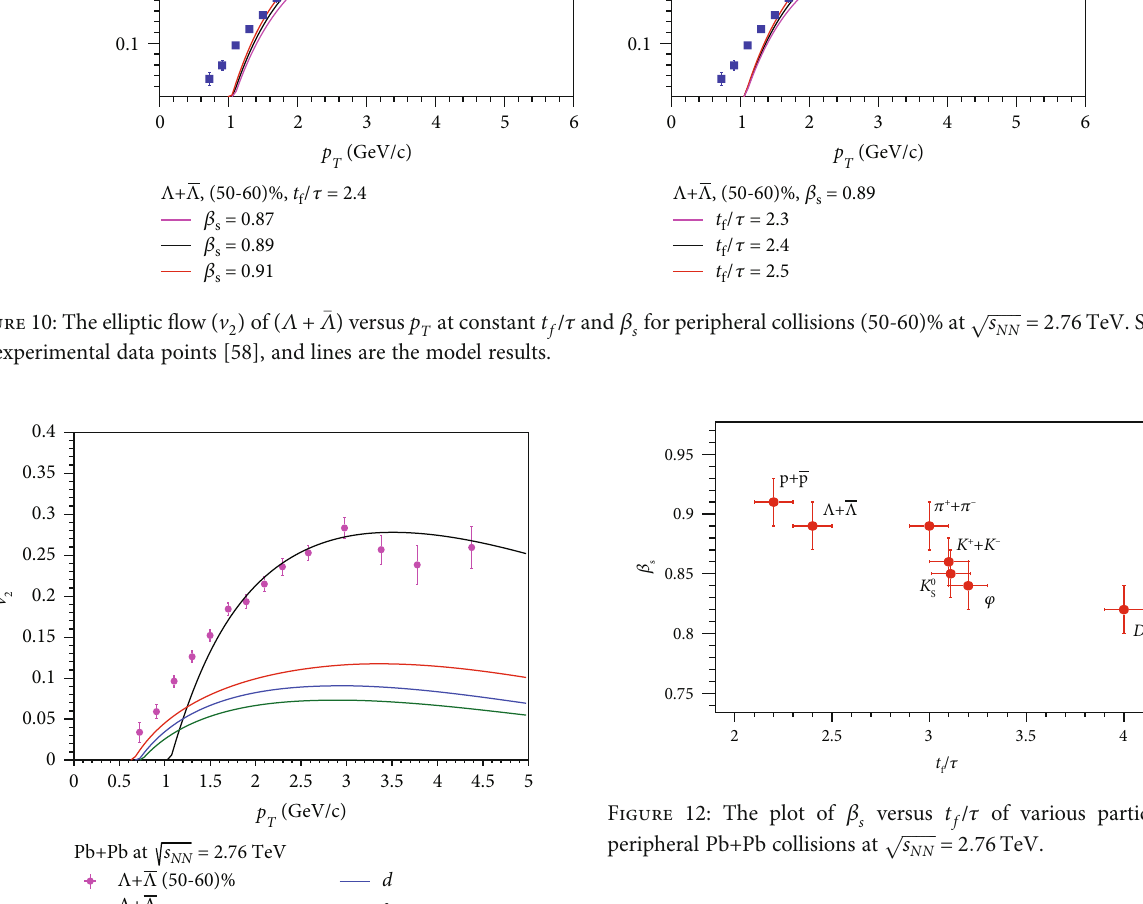
Figure 11: Comparison of v hadron v 2 for peripheral Pb+Pb collisions at